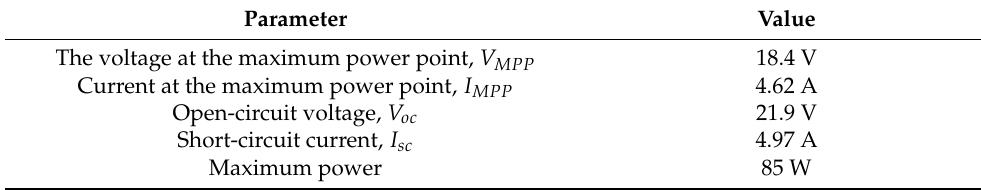
Table 2. Parameters of the PV array at T = 25 ◦ C and G = 1 Sun.